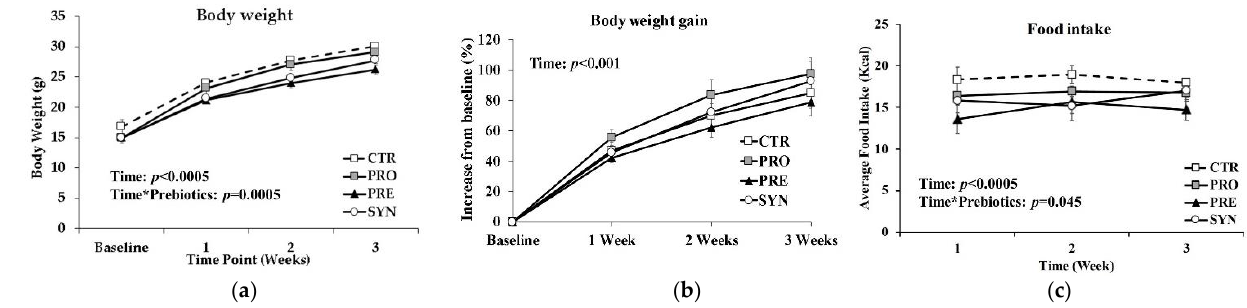
Figure 1. Body weight gain and food intake of BTBR mice consuming control, probiotic, prebiotic, or synbiotic diets for three weeks. ( a ) Body weight over time; ( b ) body weight gain (% increase from baseline); ( c ) average daily food intake (kcal/day). Values or mean ± SEM, n = 12/group. p -values presented in the figure represent the main effects and interaction effects from the repeated measures ANOVA. CTR, control; PRO, probiotic; PRE, prebiotic; SYN, synbiotic.